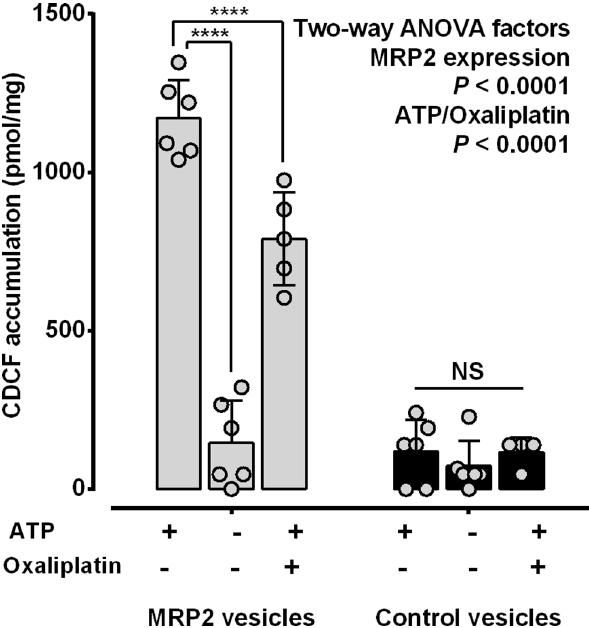
Fig 1. ATP-dependent accumulation of CDCF in MRP2-expressing membrane vesicles: inhibition by oxaliplatin. MRP2-expressing and control membrane vesicles were incubated with CDCF (5 μ M) for 5 min with or without ATP (4 mM) and oxaliplatin (400 μ M), before measurement of CDCF accumulation by fluorescence. The P values shown as numbers are from two-way ANOVA and those shown as *** ( P < 0.001) and N.S. ( P > 0.05) are from Tukey ’ s multiple comparison post-tests following two-way ANOVA for comparisons with the respective membrane vesicles incubated with ATP but no oxaliplatin. Bars represent the means and standard deviations of individual values (open symbols) pooled from two independent experiments. Grey bars, MRP2-expressing membrane vesicles. Black bars, control membrane vesicles.